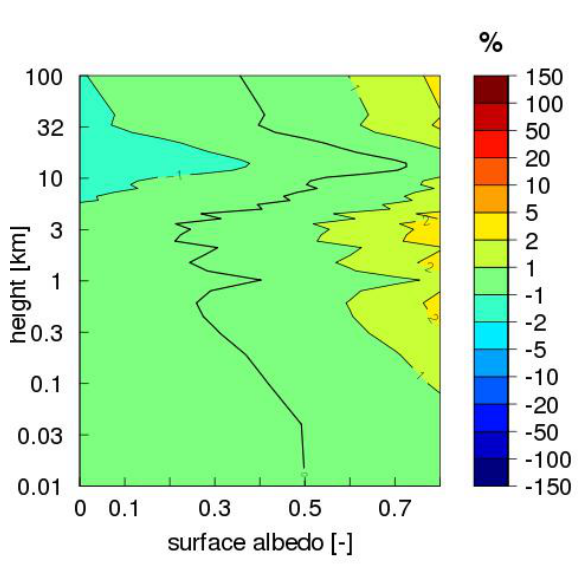
Figure 6. As for Fig. 2 but for IFS compared to Kato-DISORT as a function of surface albedo (experiment